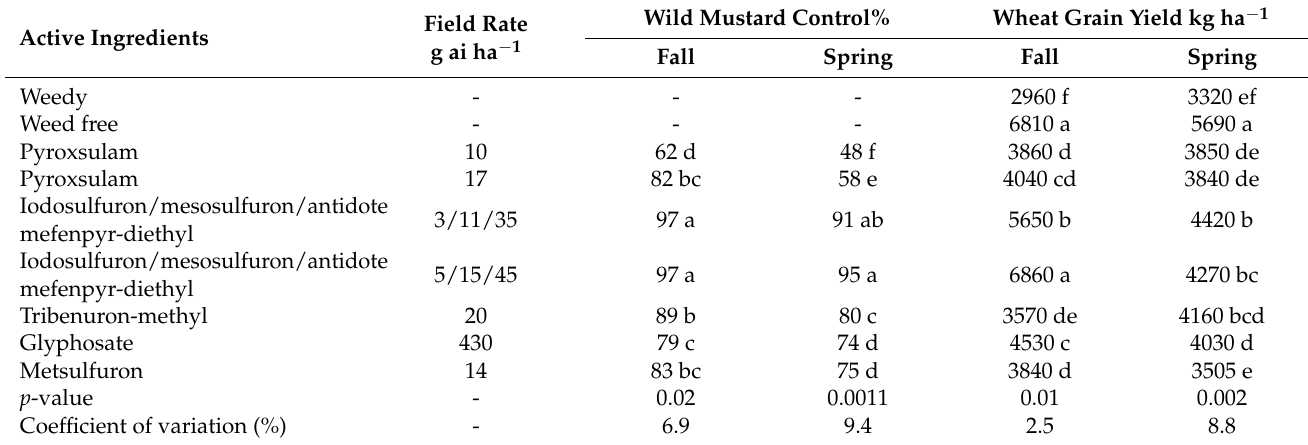
Table 3. Wild mustard control and wheat grain yield after fall and spring herbicide applied preplant at Baribino 2019. Active